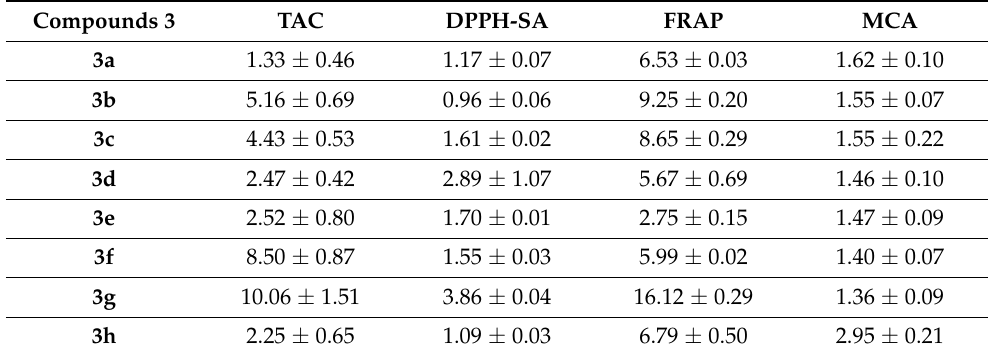
Table 2. Antioxidant activities of target benzimidazole-urea 3a-h